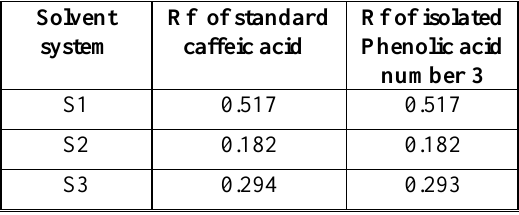
Table 5. TLC profile of isolatedi compound number 3 compared with caffeic acid standard using the mobile phase solvents ( S1, S2, S3).